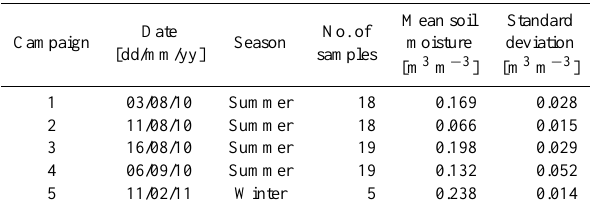
Table 2. Description of soil sampling campaigns at experimental